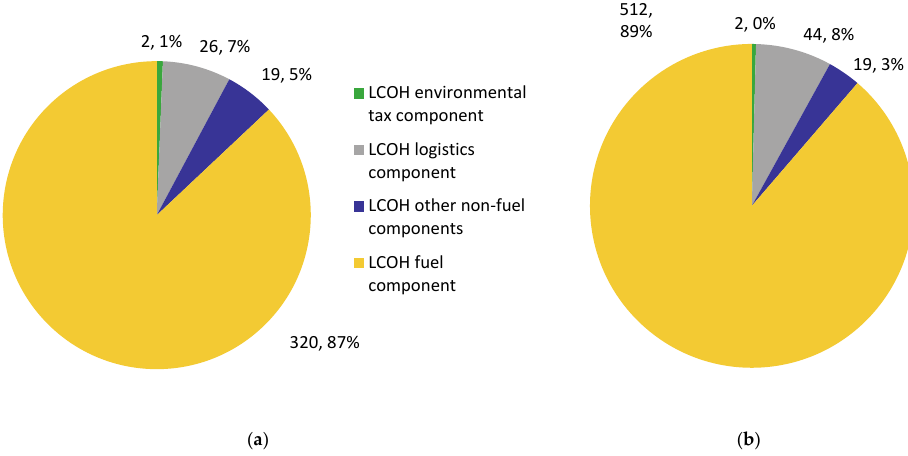
Figure 4. LCOH structure from KZOT BRS 1000 Comfort BM (1 MW) from wood pellets: ( a ) January 2022; ( b ) July 2022.